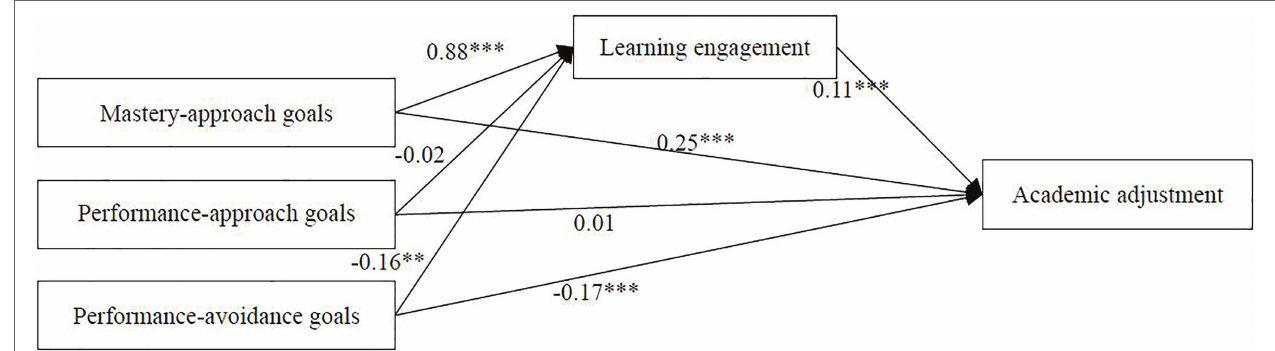
FIGURE 2 | The proposed mediated model on variable level. ** p < 0.01, *** p < 0.001.